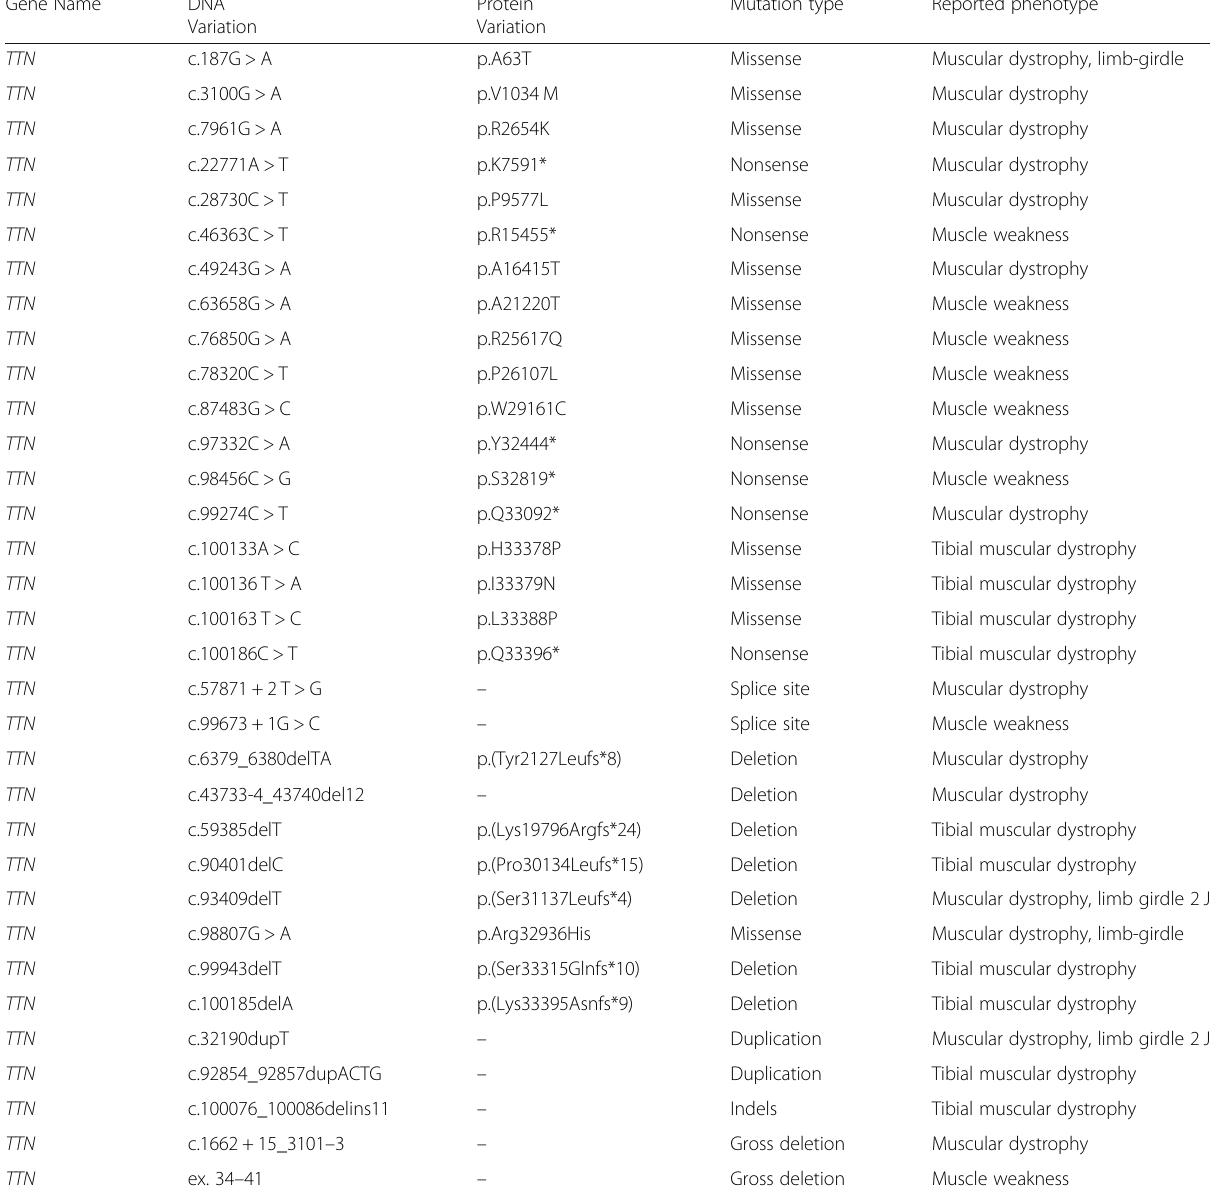
Table 3 HGMD reported mutations in TTN gene associated with LGMD